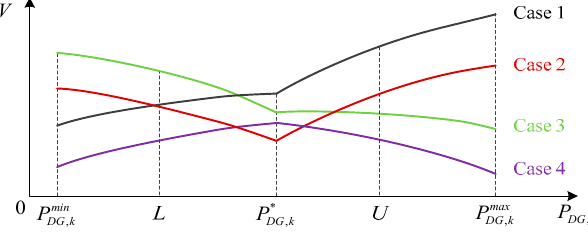
Figure 6. Possible trajectory of the node voltage magnitude with the two ‐ segment Q–P droop controller.